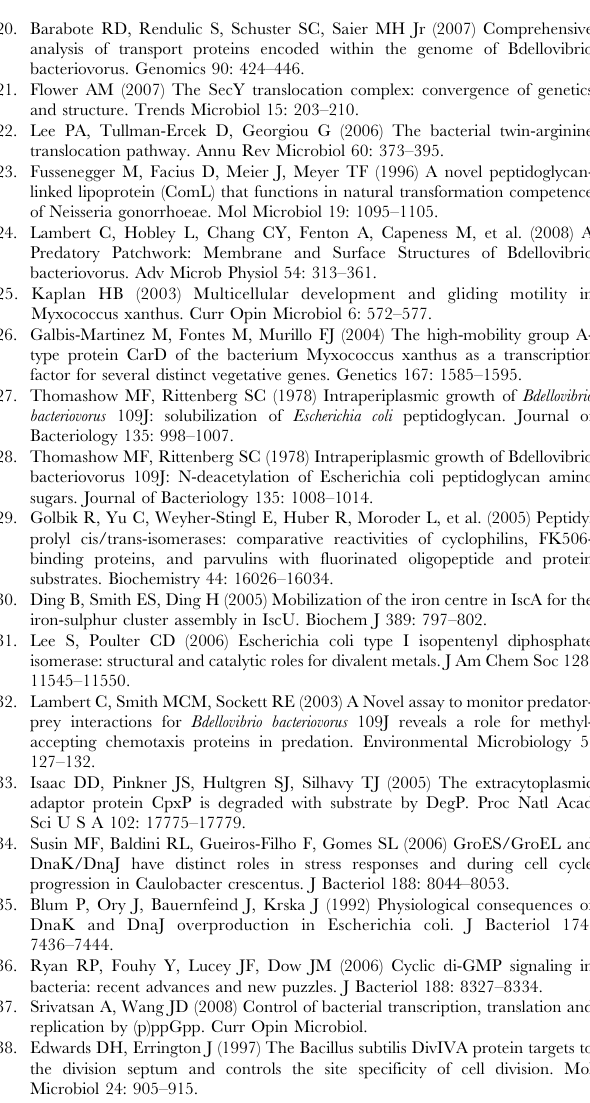
Figure S1 Expression data by category. Excel file showing fold- differential expression for each gene set. Fold-Change 1 was calculated by calculating the fold-change of each paired datapoint and averaging all of these for every gene. Fold-Change 2 was calculated by averaging the normalised expression of each datapoint for a gene and calculating the fold-change between experimental conditions for each gene. The T-test shown was a paired, 2 tailed test for each comparative experimental condition. Found at: doi:10.1371/journal.pone.0008599.s001 (1.16